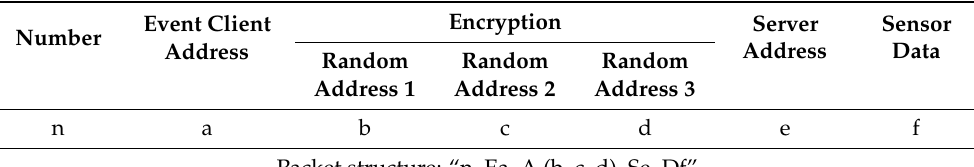
Table 1. Packet structure transmitted when an event has